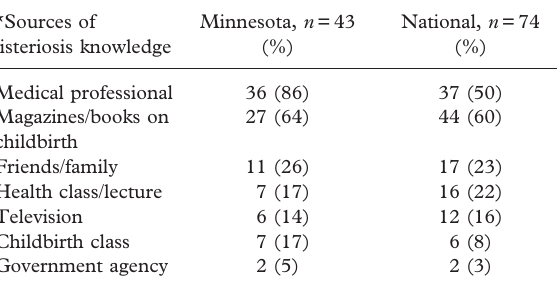
Table II. Sources of listeriosis information among survey respondents who indicated knowledge of